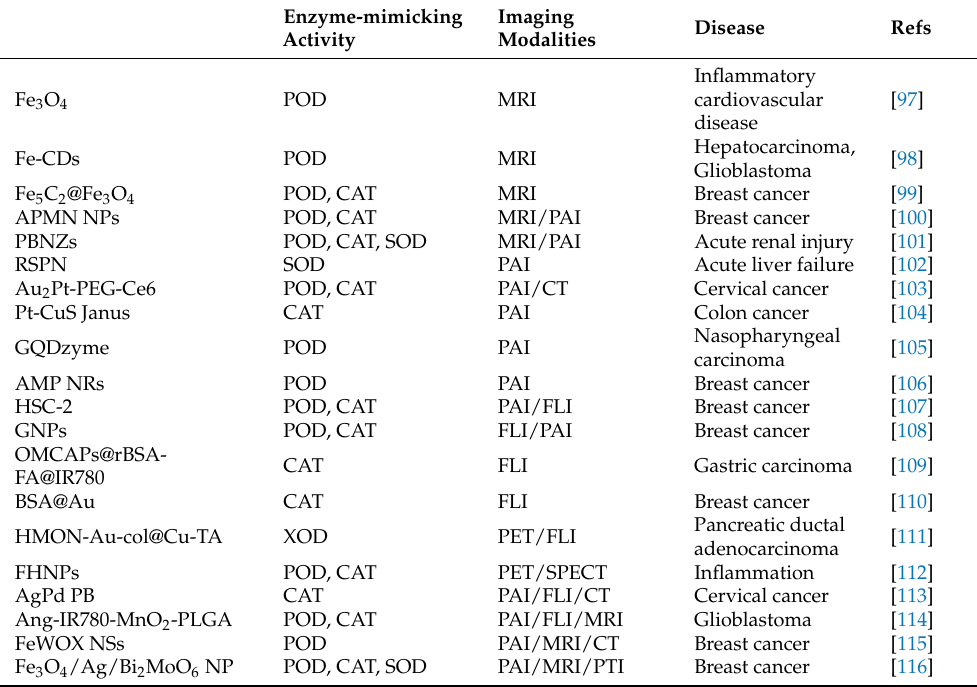
Table 1. Summary of typical nanozymes applied in different imaging